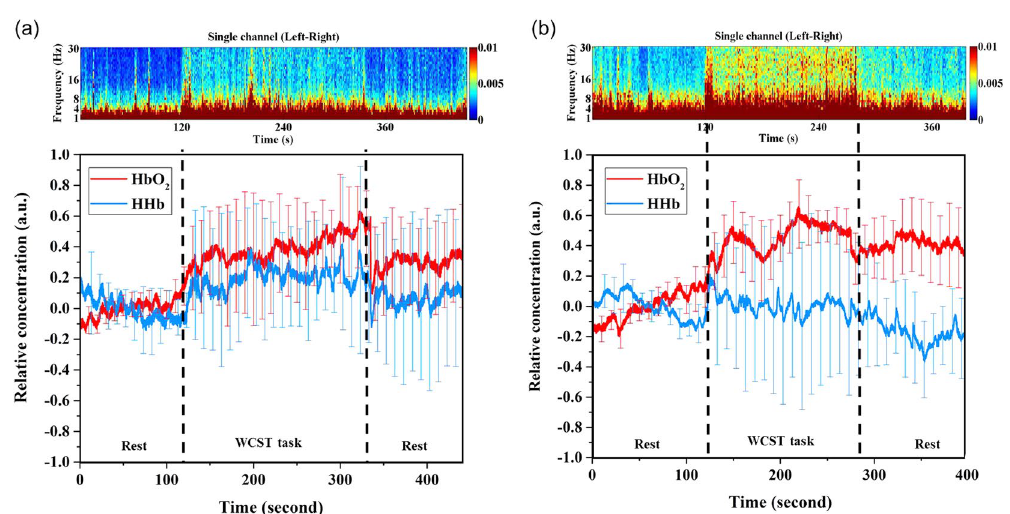
Figure 1. NIRS and EEG data for ( a ) Group 1 and ( b ) Group 2. The top portions of the figure depict the difference between the left channel (FP1) and right channel (FP2) EEG signals. The bottom portions of the figure show NIRS signals for the blood oxygenation changes. The red line is the HbO 2 concentration and the blue line is the HHb concentration. The x-axis is the experimental time and the y-axis is the change in